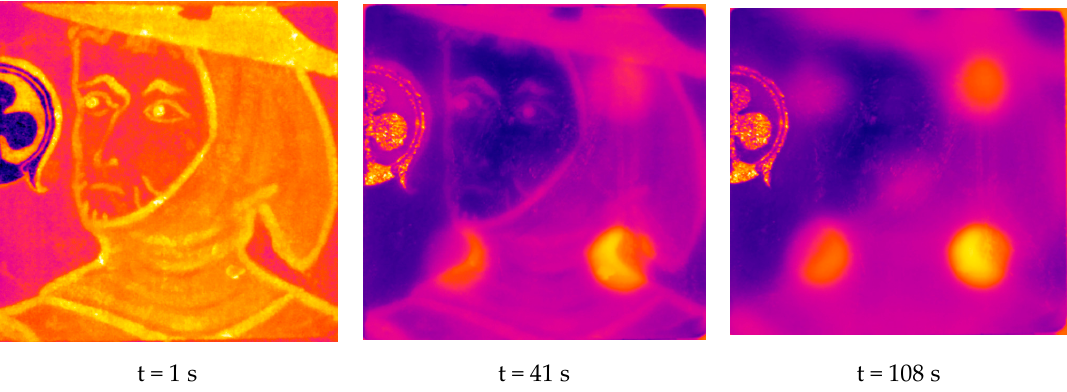
= 1 s, t = 41 s and t = 108